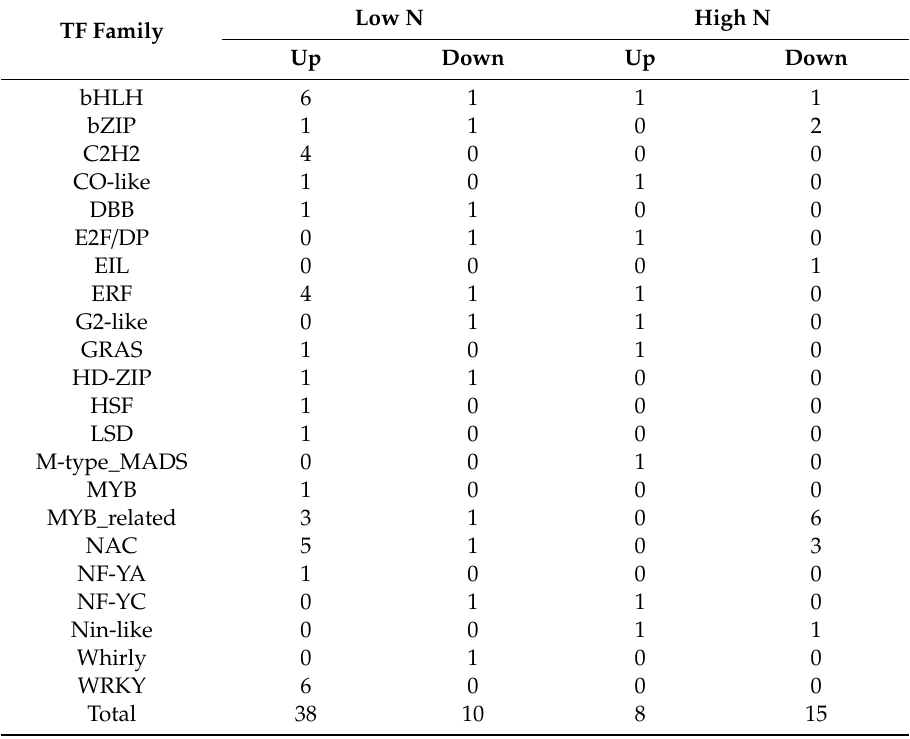
Table 2. Transcription factors (TFs) di ff erentially expressed under low N and high N. Low N High N TF Family Up Down Up